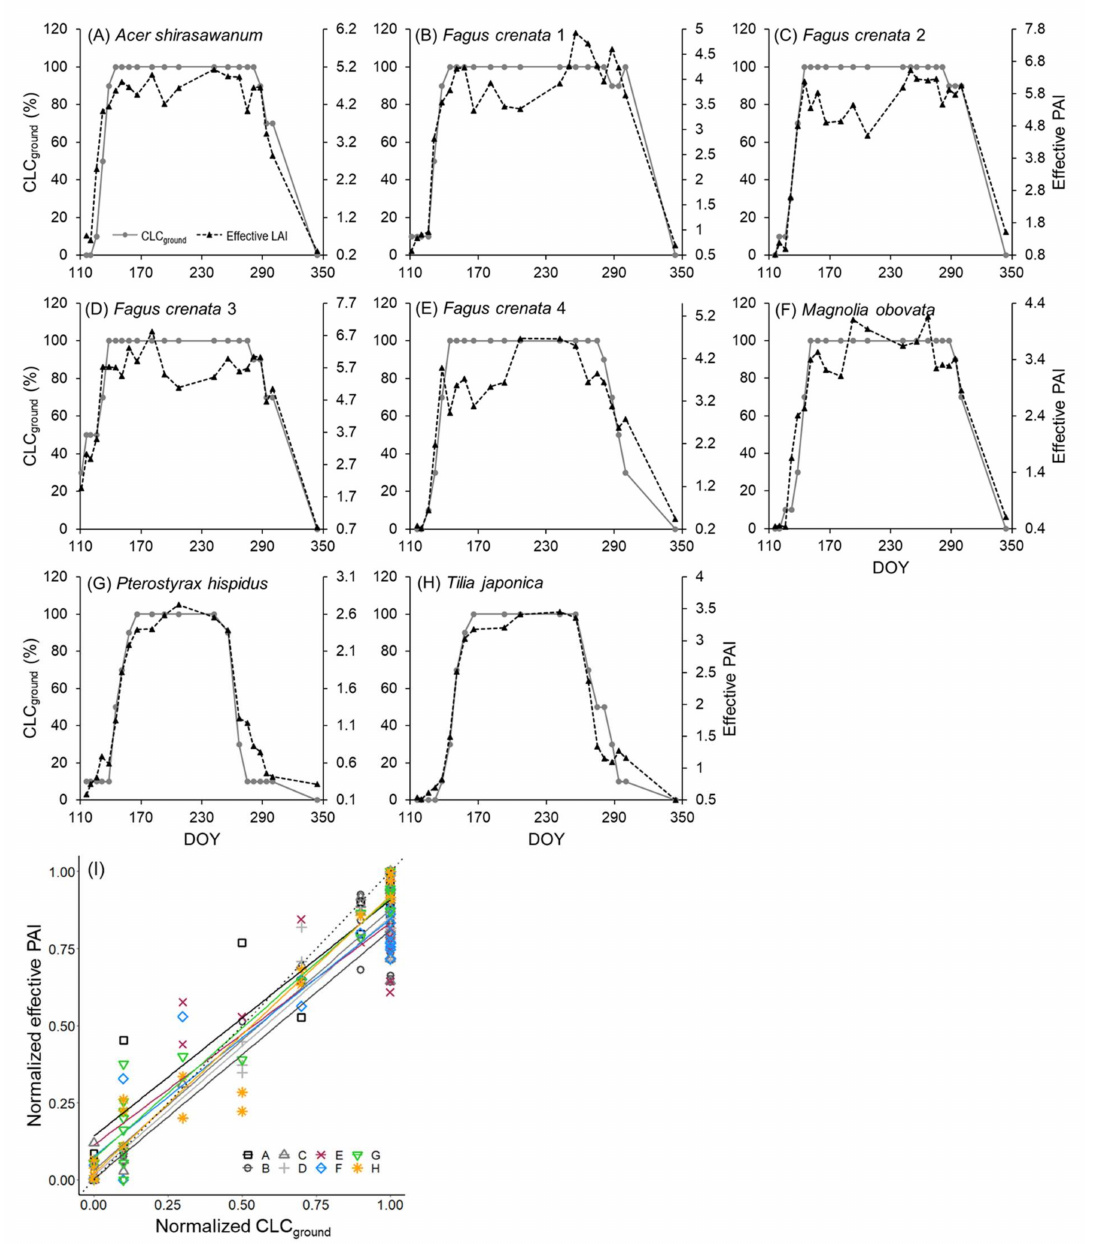
Figure A2. Comparison between effective plant area index (PAI) derived from digital hemispherical photographs (DHP) and crown leaf cover based on the ground observation (CLC ground ) for eight canopy trees measured in 2021. To quantify effective PAI from DHP at individual tree level, we chose samples with a large crown but small influence from neighboring trees. The DHP images were acquired using a Nikon D5100 camera (Nikon, Tokyo, Japan) fitted with a 4.5-mm F2.8 EX DC circular fisheye converter (SIGMA, Kanagawa, Japan) and were imported into ImageJ software for post-processing. We defined the processing range for DHP using the circle of interest adjusted according to the crown edges of the individual trees, and calculated effective PAI using CIMES software [66]. All values on panel ( I ) are normalized to a scale of 0 to 1. Dotted lines are 1:1 lines, and solid lines are linear regression equations as follows: ( A ) y = 0.766 x + 0.142, r 2 = 0.886, root mean square error (RMSE) = 0.140; ( B ) y = 0.806 x + 0.003, r 2 = 0.903, RMSE = 0.191; ( C ) y = 0.844 x + 0.032, r 2 = 0.912, RMSE = 0.144; ( D ) y = 0.838 x + 0.015, r 2 = 0.876, RMSE = 0.152; ( E ) y = 0.720 x + 0.113, r 2 = 0.828, RMSE = 0.187; ( F ) y = 0.769 x + 0.076, r 2 = 0.902, RMSE = 0.164; ( G ) y = 0.845 x + 0.070, r 2 = 0.945, RMSE = 0.104; ( H ) y = 0.899 x + 0.022, r 2 = 0.943, RMSE =